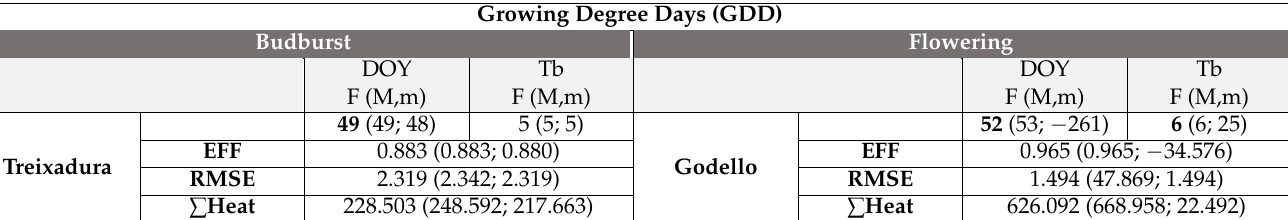
Table 3. Phenological models selected to predict the dates of budburst and flowering. DOY: day of the year, Tb: base temperature, F: fitted, (M, m): maximum and minimum values